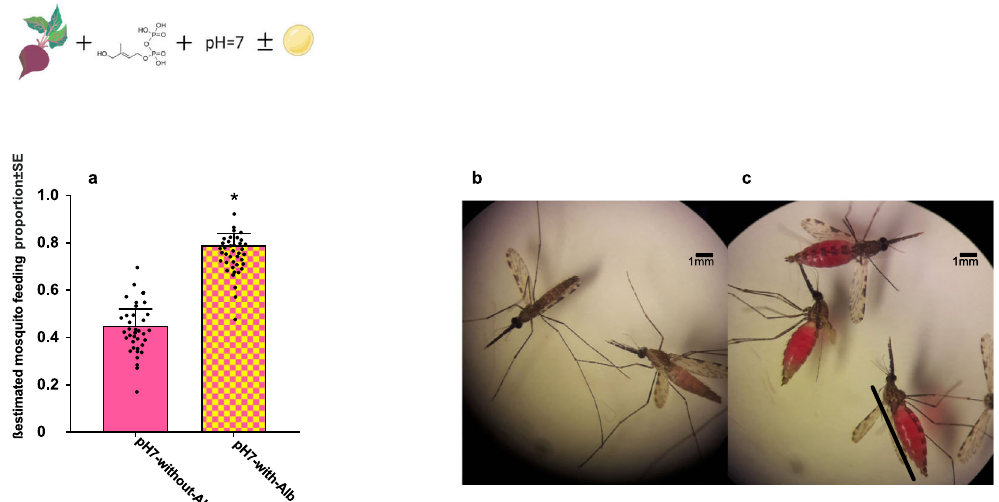
Fig. 3 Mosquito feeding on a plant-based solution containing phagostimulant, HMBPP, adjusted to pH7, with and without lipid/protein addition. a Percentage of mosquitoes feeding within ten minutes on pH = 7 of plant-based solution with and without AlbuMAX TM (pH7-with-Alb vs pH7-without-Alb) in Anopheles gambiae s.l. [ χ 2 1 = 6.26, p = 0.01]. In this experiment, the left bar controls, and the right bar is the treatment. Bars represented by β -estimation generated by the mixed model ± SE ( β -lmer ± SE); asterisks denote signi fi cant differences ( n = 120, * P < 0.05, ** P < 0.01, *** P < 0.001). b , c An. gambiae s.l . mosquitoes after feeding on plant-based mixtures varying in lipid content at physiological pH. Mosquitoes were exposed to feeding mixtures ( b ) without AlbuMAX TM and ( c ) with AlbuMAX TM for 10 min (scale bar: 1.0